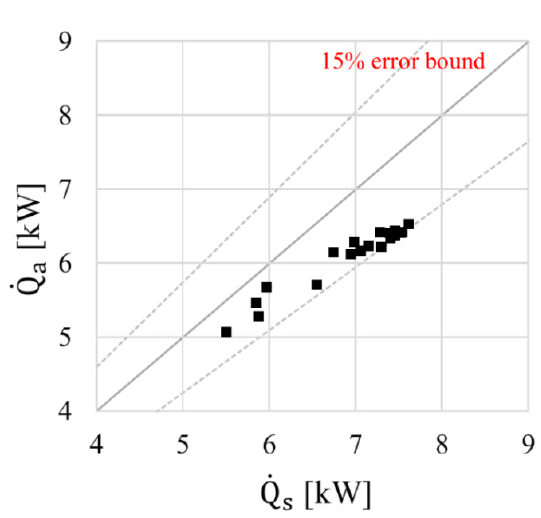
Figure 8. Internal energy variations of the solution and air.